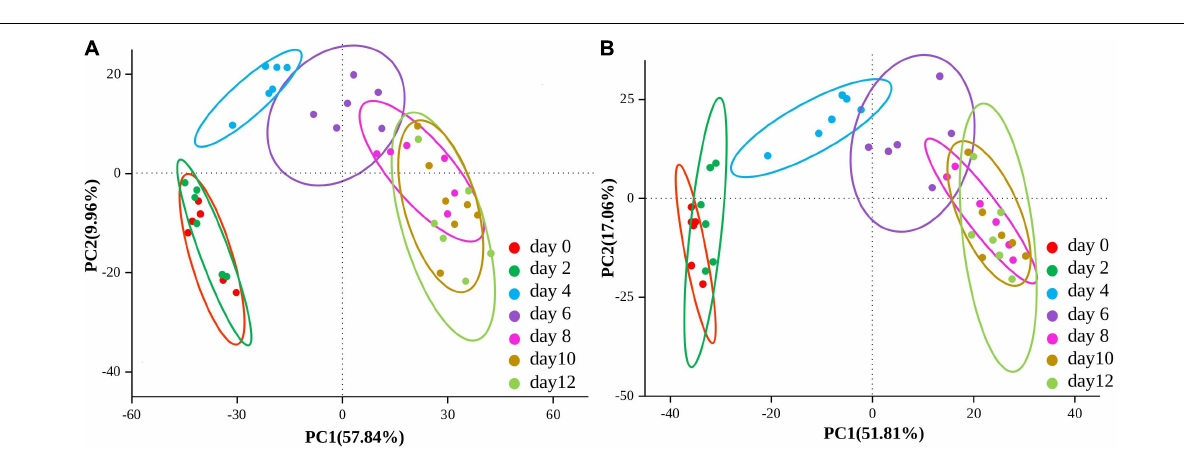
FIGURE 4 | Score plots of the principal component analysis (PCA) of both positive (A) and negative (B) ion mode of non-volatile metabolites at different stages of